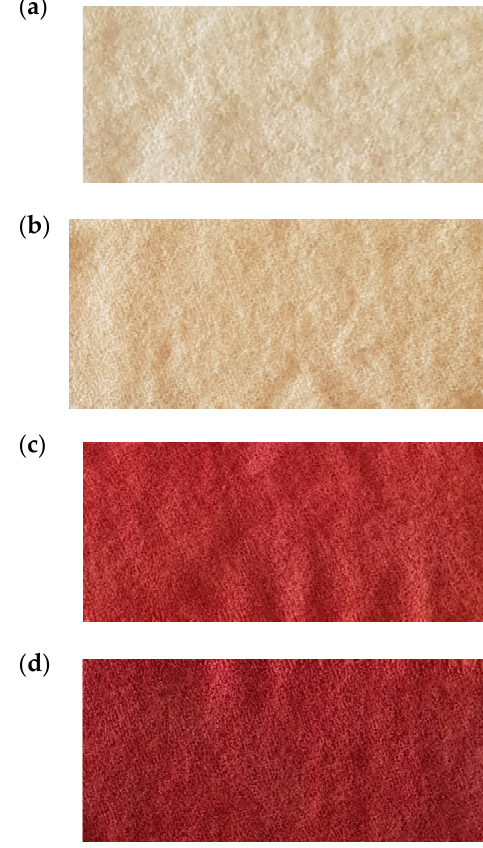
Figure 17. Images of wool samples without and with functionalization, after dyeing: ( a ) untreated wool; ( b ) untreated but dyed wool; ( c ) FAAD sample; ( d ) FAAW sample.